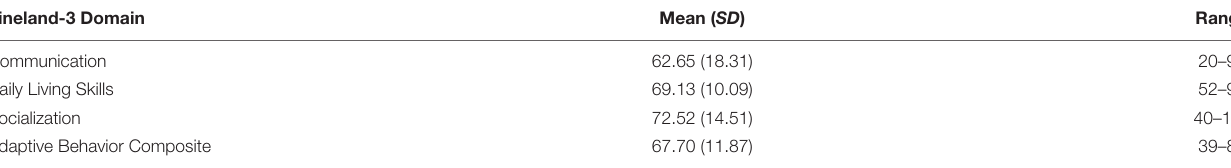
TABLE 10 | Vineland-3 scores ( n =